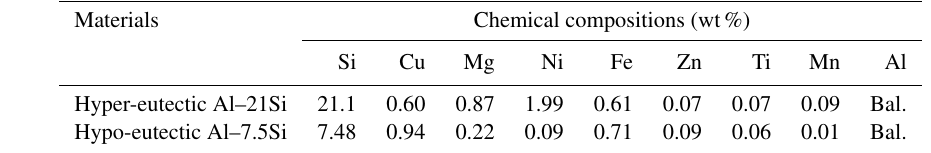
Table 1. Chemical compositions of the materials (wt%).